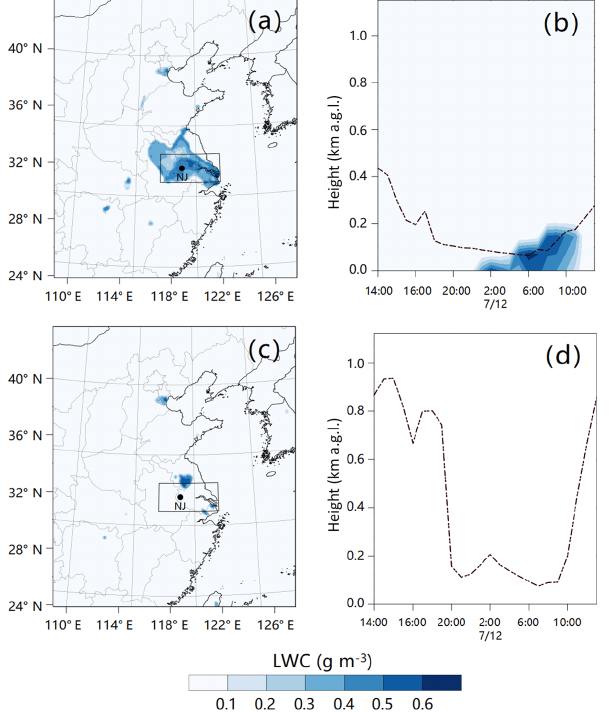
Figure 6. The distribution of LWC ns from EXP_CTL (a) and EXP_NOAER (c) at 08:00LST on 7 December and the vertical dis- tribution of LWC at Nanjing from EXP_CTL (b) and EXP_NOAER (d) , varying from 14:00LST on 6 December to 14:00LST on 7 De- cember. The dashed line denotes the PBLH.